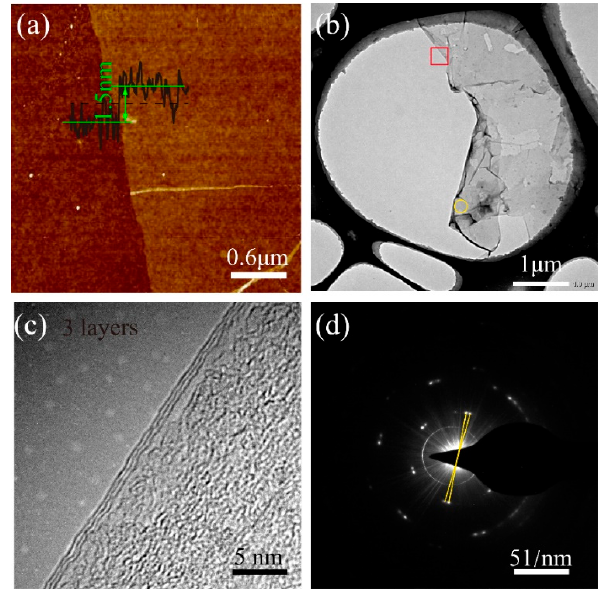
Figure 5. Characterization of the as-grown graphene film that was grown in 30 min. ( a ) A typical atomic force microscopy (AFM) image with the height of the cross-section. ( b ) Low-magnification TEM image. ( c ) High–resolution TEM image at the back-folded edges (red box in b), identifying a trilayer graphene. ( d ) Selected area electron di ff raction (SAED) pattern (yellow circle in b) at normal